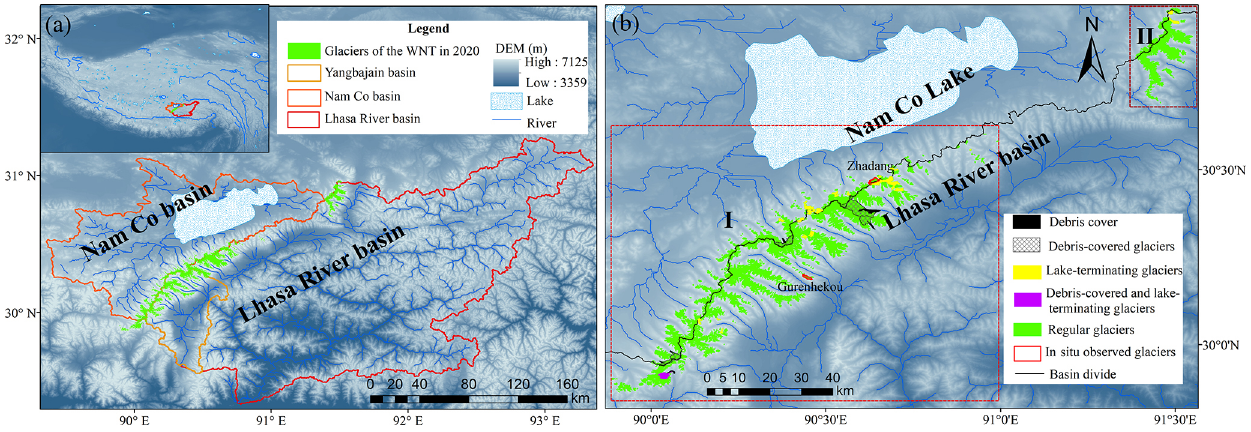
Figure 1. (a) Overview of the study area. (b) Glacier distribution. Label I in the large, dotted red rectangle represents the SW section of the WNR, and Label II in the small, dotted dark red rectangle represents the NE